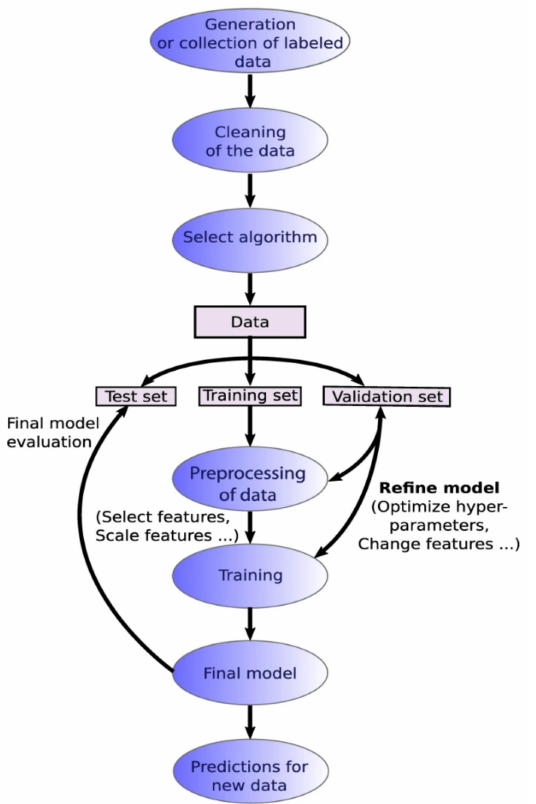
Figure 9. Supervised learning workflow. Reproduced from [107], under the terms of the Creative Commons CC BY license [18]. No changes have been